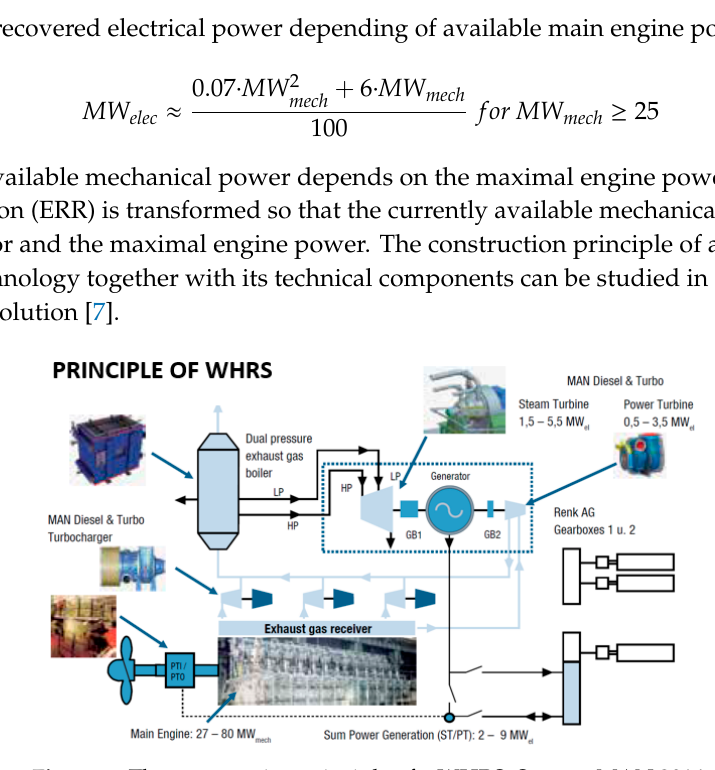
Figure 3. The construction principle of a WHRS. Source: MAN 2014.